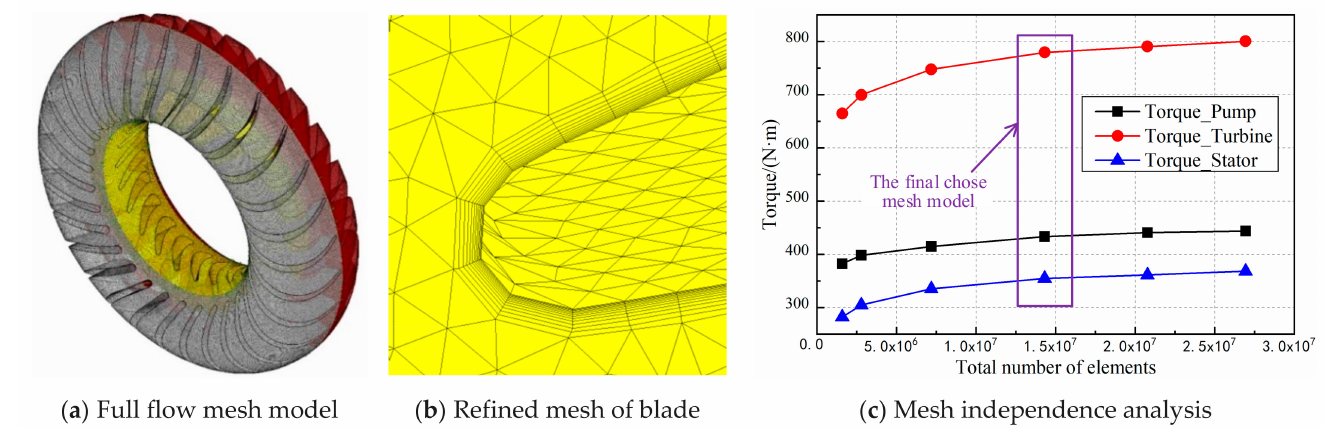
Figure 3. Mesh model and independence analysis results of torque converter.